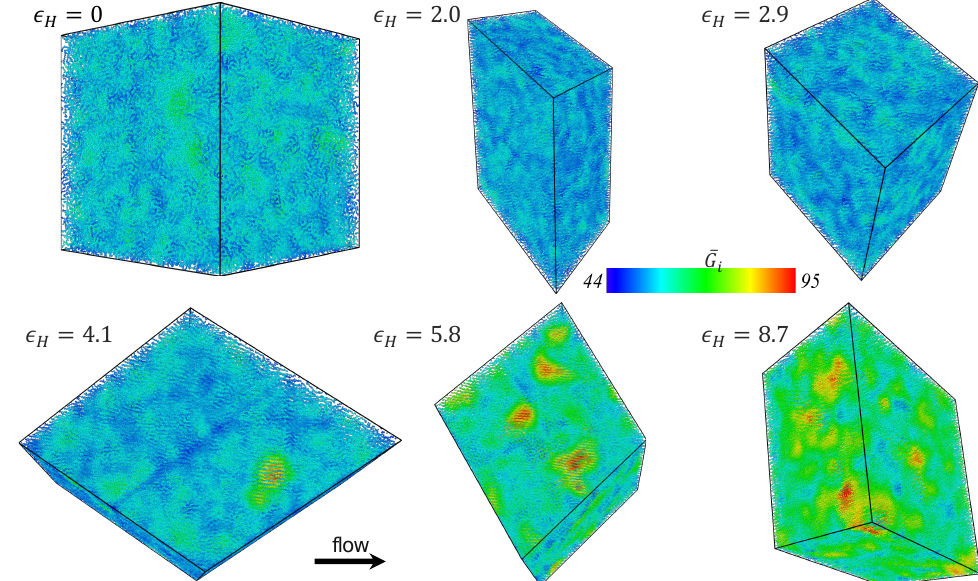
Figure 13. Snapshots of the simulation cell at various Hencky strains after startup of UEF at 450 K of the PE melt at De = 9.0. Individual atoms are colored based on their instantaneous values of ¯ G i , according to the legend color bar. Note that the boxes are displayed at random angles (and sizes) relative to the flow direction because the simulation cell rotates (and elongates/compresses) with time under UEF due to the imposed boundary